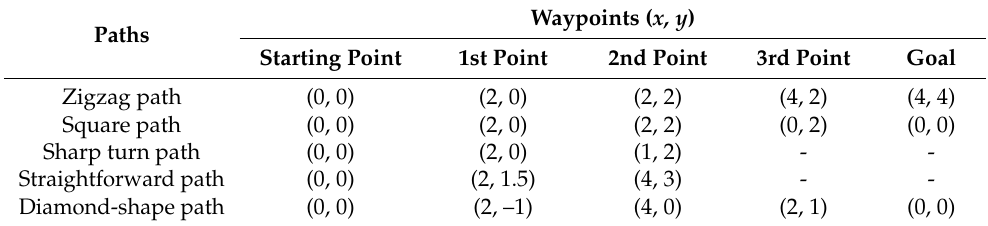
Table 7. Parameters of the paths used for